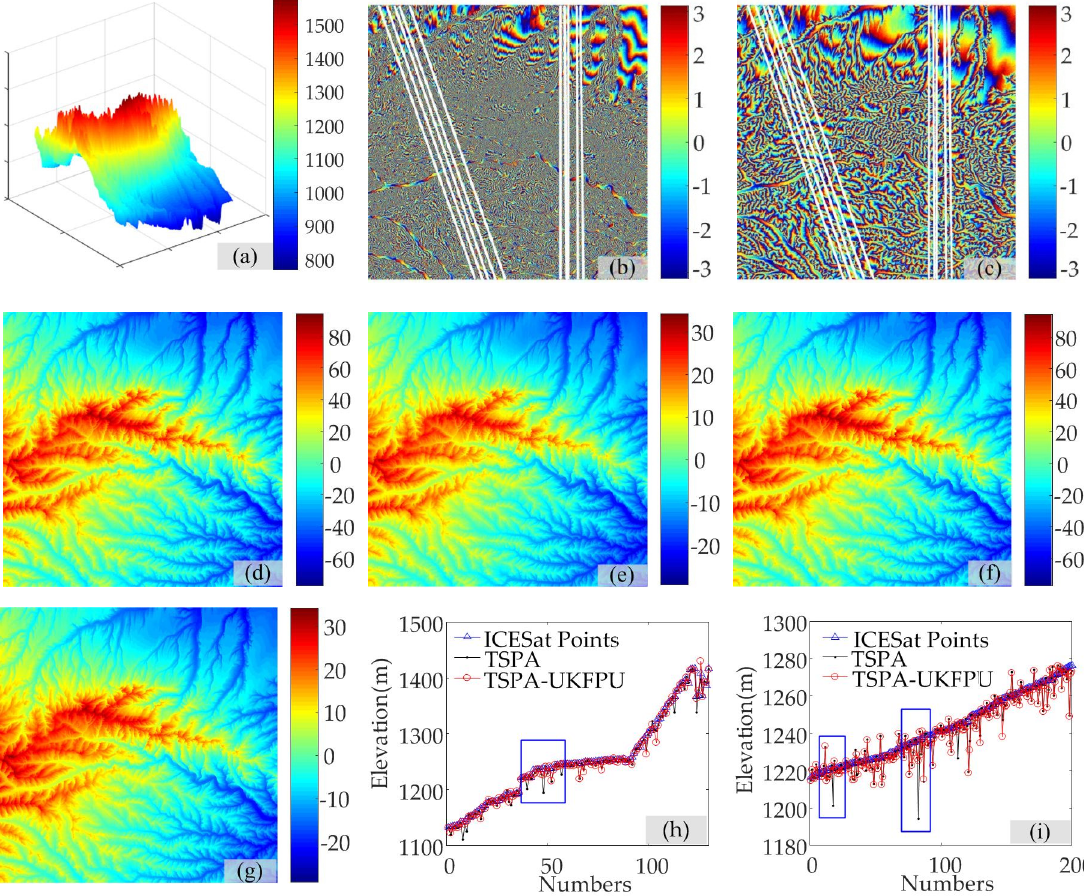
Figure 7. ( a ) 3-D display of TerraSAR-X add-on for Digital Elevation Measurement (TanDEM-X) digital elevation models (DEM). ( b ) Real interferogram with long normal baseline. ( c ) Real interferogram with short normal baseline. ( d ) Phase unwrapping (PU) result of (a) obtained by two-stage programming approach (TSPA). ( e ) PU result of (b) obtained by TSPA. ( f ) PU result of (a) obtained by TSPA-UKFPU. ( g ) PU result of (b) obtained by TSPA- unscented Kalman filter (UKF)PU. ( h ) The ICESat elevation results of (b) obtained by different method. ( i ) The portion elevation results of (c) obtained by different methods. Table 3. Major parameters of the employed TerraSAR-X add-on for Digital Elevation Measurement (TanDEM-X) data.